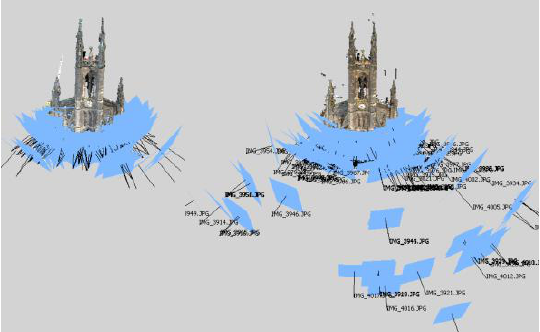
Figure 2. Camera positions of photoset 1(left) and 2